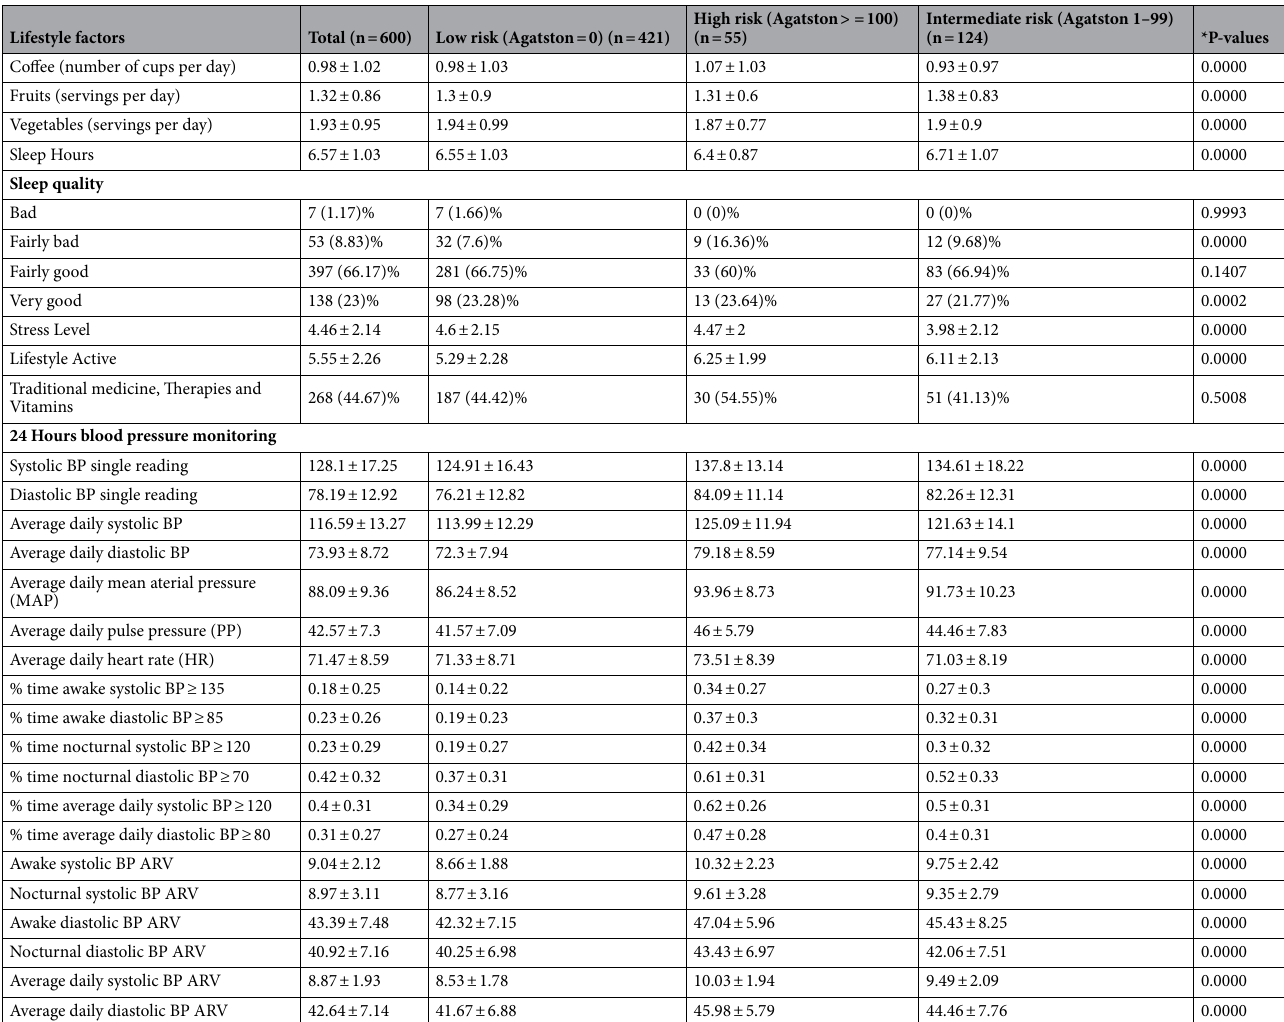
Table 3. Self-reported lifestyle factors and 24 h blood pressure and heart rate monitoring data by risk categories.